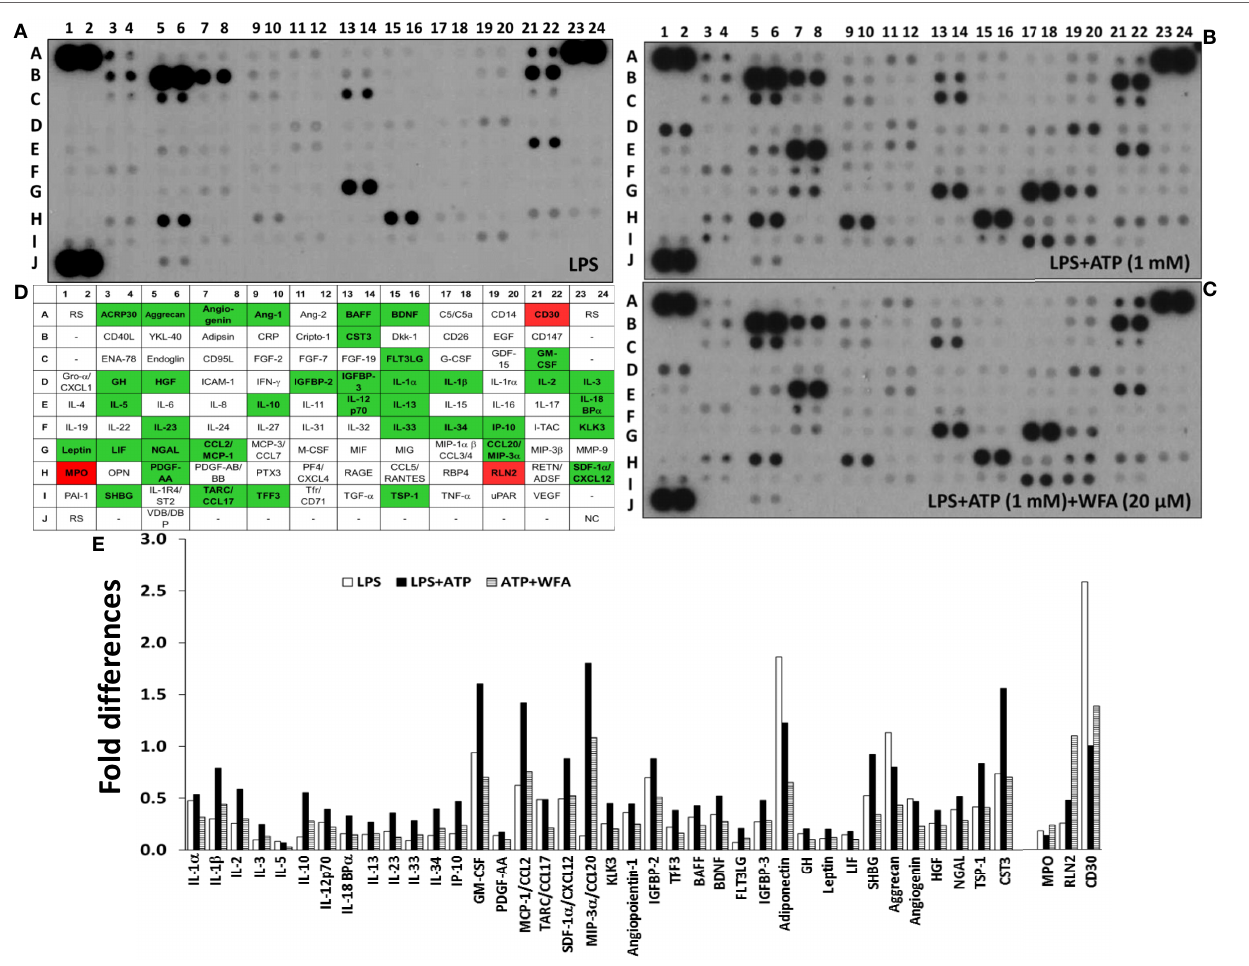
FigUre 1 | Differential cytokine/chemokine production levels modulated via withaferin A (WFA) in THP-1 cells. THP-1 cells at a density of 5 × 10 5 cells/well were seeded in six-well plates in the presence of phorbol myristate acetate (500 ng/mL). Following overnight incubation, lipopolysaccharide (LPS) (200 ng/mL) was added for 2 h, and the cells were primed with adenosine triphosphate (ATP) (1 mM) for 30 min. Collective analysis of 102 cytokines in the culture supernatant from THP-1 cells treated with LPS [ (a) control] primed with ATP (B) and treated with WFA (c) . (D) A schematic representation of the cytokine/chemokine spot positions in duplicate on the membrane with respective internal controls. Rectangles filled with green background represents downregulation ( > 1.5-fold), and with red background represents upregulation ( > 1.5-fold) of cytokines/chemokines following WFA treatment. RS, reference spots; NC, negative controls; - , blank (no spot). (e) The relative fold change in differentially expressed genes ( > 1.5-fold). The quantitative analysis of the pixel intensity data did not provide P -values to demonstrate significance